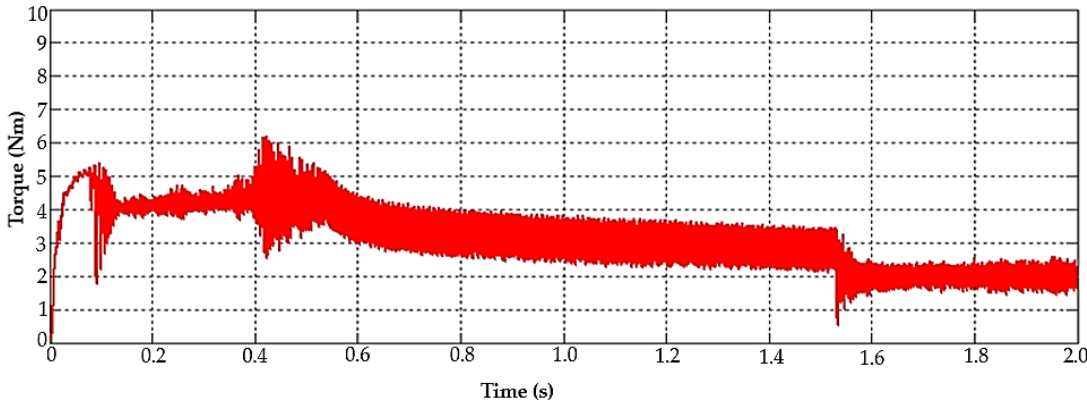
Figure 10. Steady-state response of the BLDC motor speed.